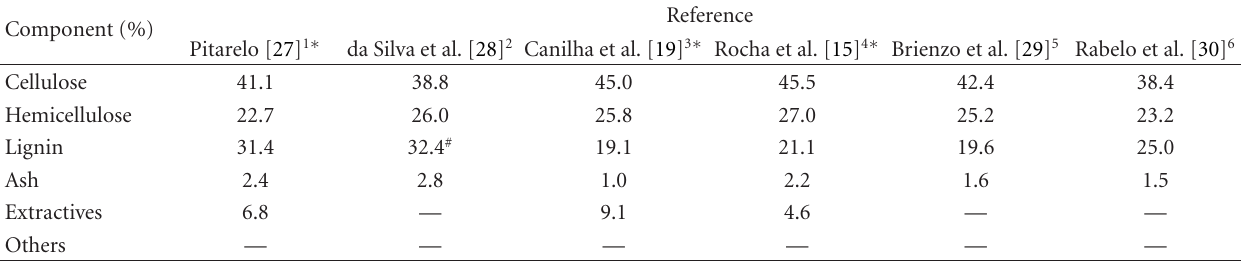
Table 2: Chemical composition (% w/w, dry basis) of Brazilian SB reported in the